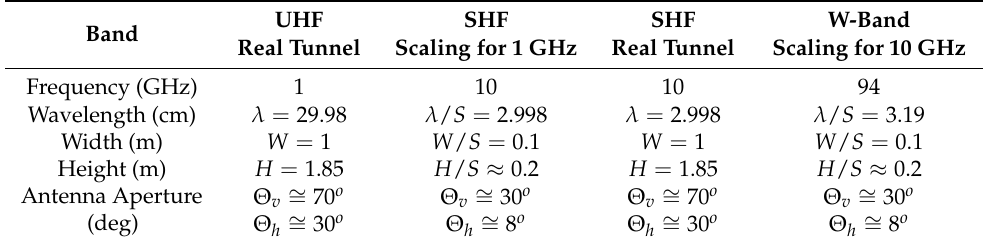
Table 2. Parameters of the real tunnel and its subscale model.